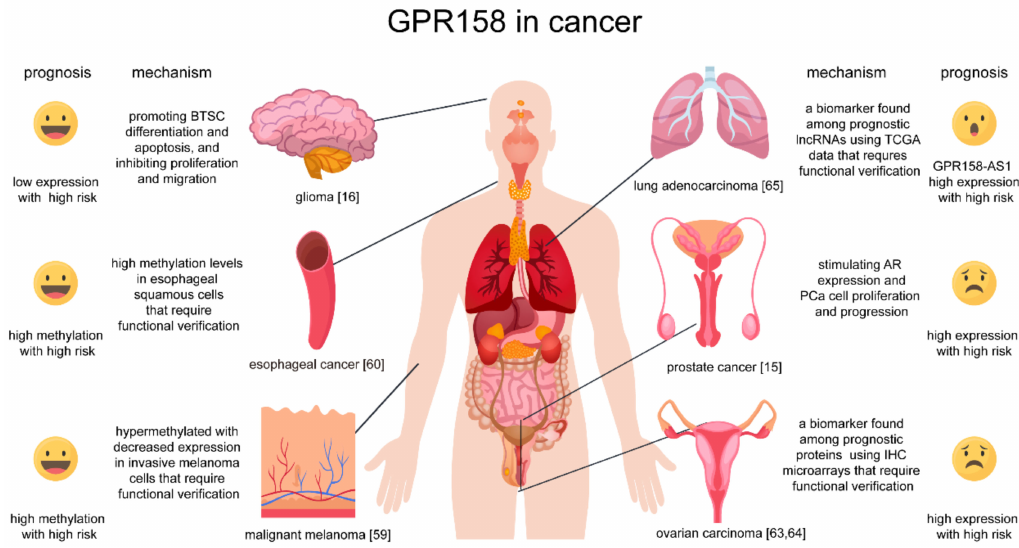
Figure 4. Roles of GPR158 in cancer. Current reports on the role of GPR158 in cancer. GPR158 may play different roles in different cancers. Smile icons indicate that high expression of GPR158 has a favorable prognosis, while sadness icons for high expression of GPR158 with a poor prognosis, and the surprise icon on the prognostic correlation for further verification. IHC, immunohistochemistry; BTSC, brain tumor stem cells; TCGA, The Cancer Genome Atlas. The figure was designed using resources from